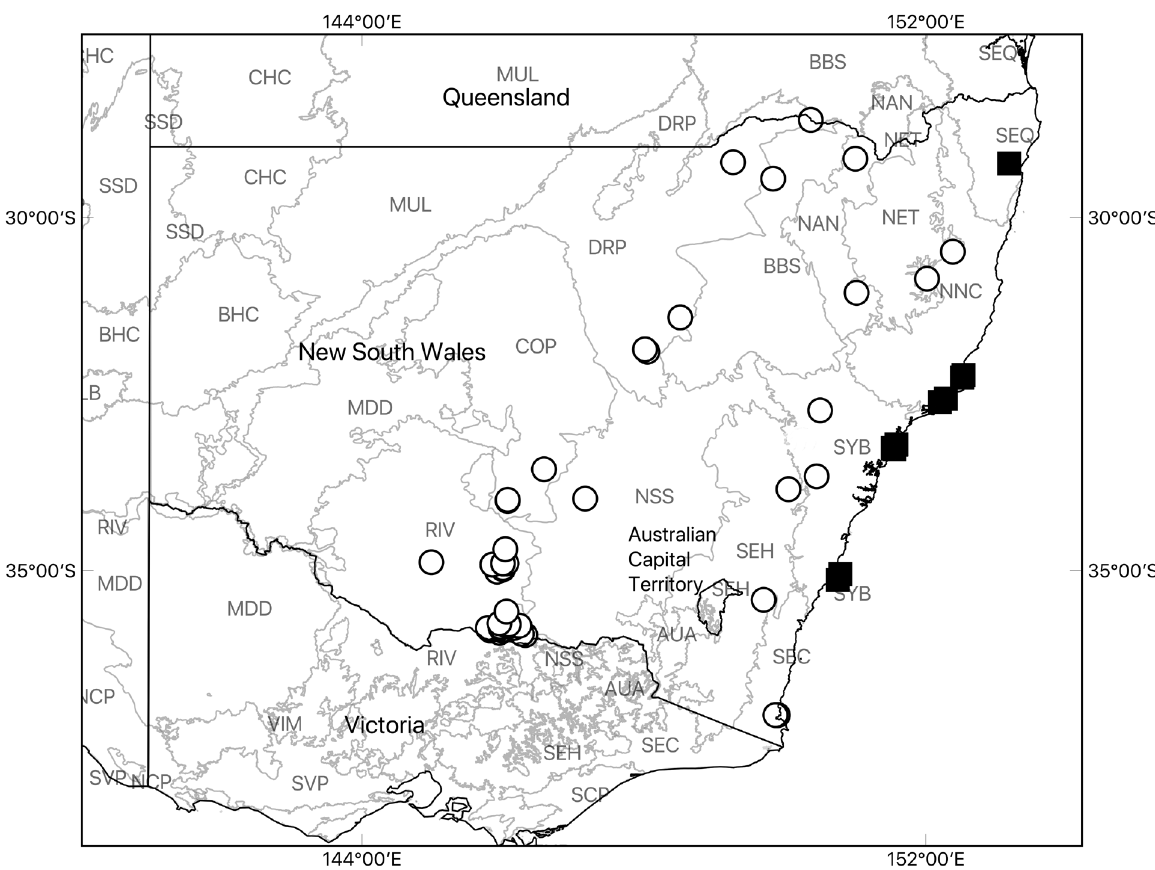
Figure 44. Distribution records of Artoria victoriensis Framenau, Gotch & Austin, 2006 (open circles) and A. wilkiei sp. n. (full squares) in NSW. IBRA bioregions with spider records: BBS – Brigalow Belt South; DRP – Darling Riverine Plains; COP – Cobar Peneplain; NAN – Nandewar; NNC – NSW North Coast; NSS – NSW South Western Slopes; RIV – Riverina; SEH – South Eastern Highlands; SEC – South East Corner; SEQ – South East Queensland; SYB – Sydney